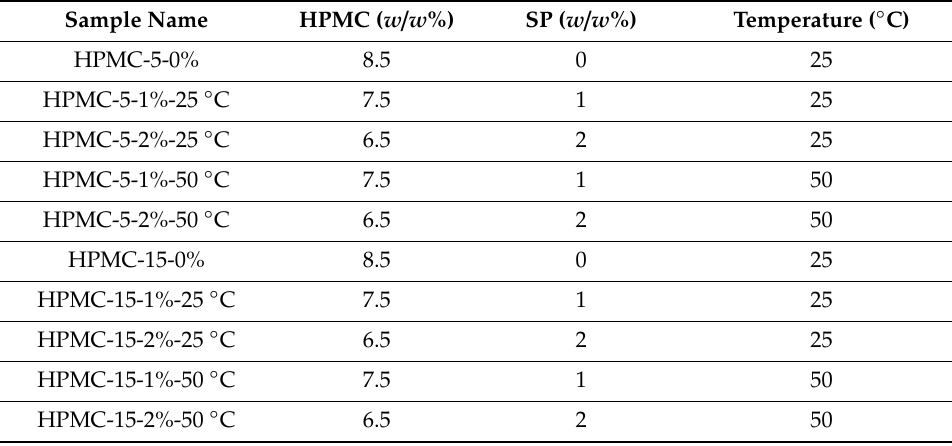
Table 6. The composition of the solutions for film